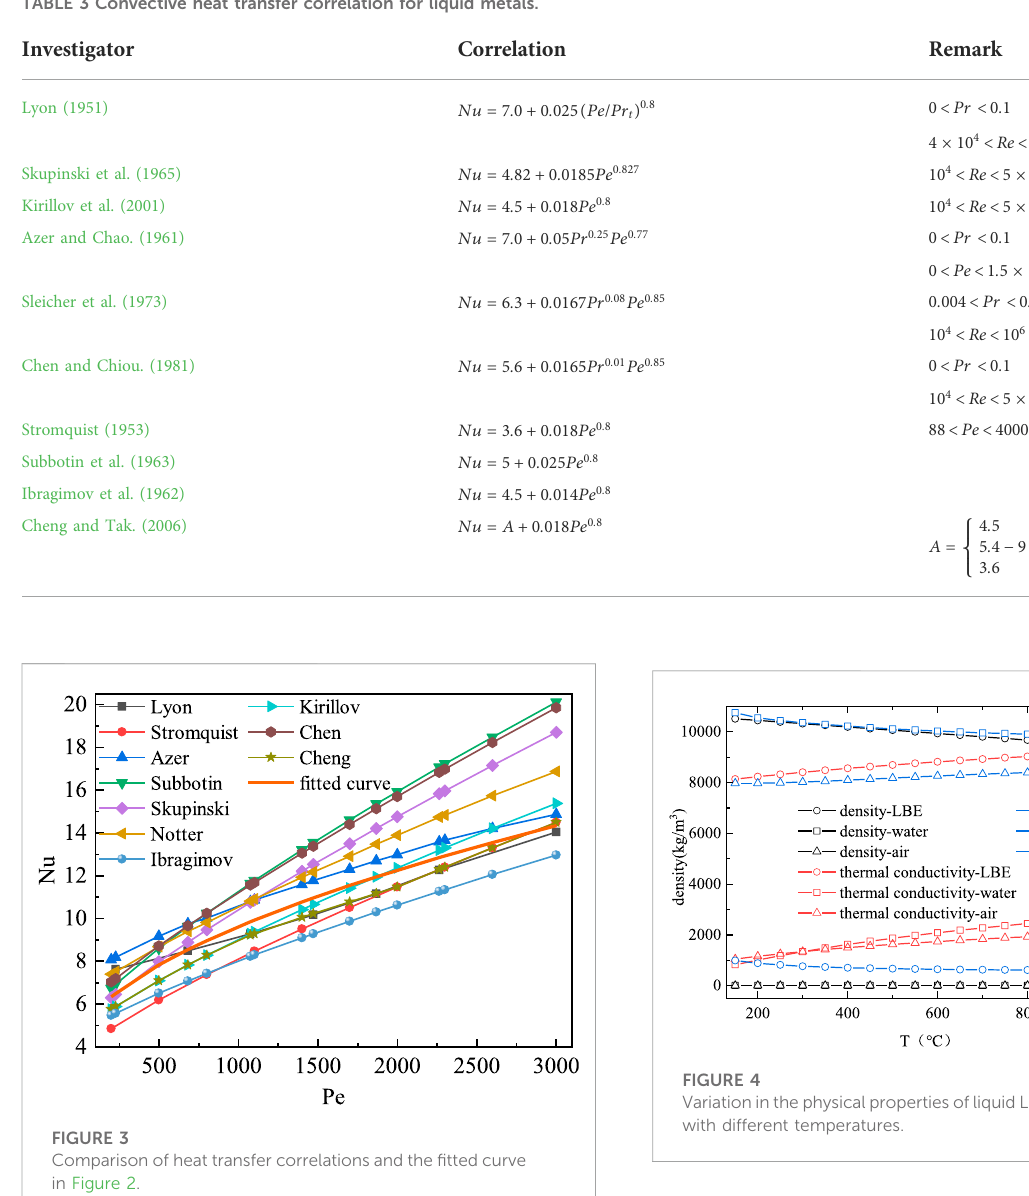
TABLE 3 Convective heat transfer correlation for liquid metals.